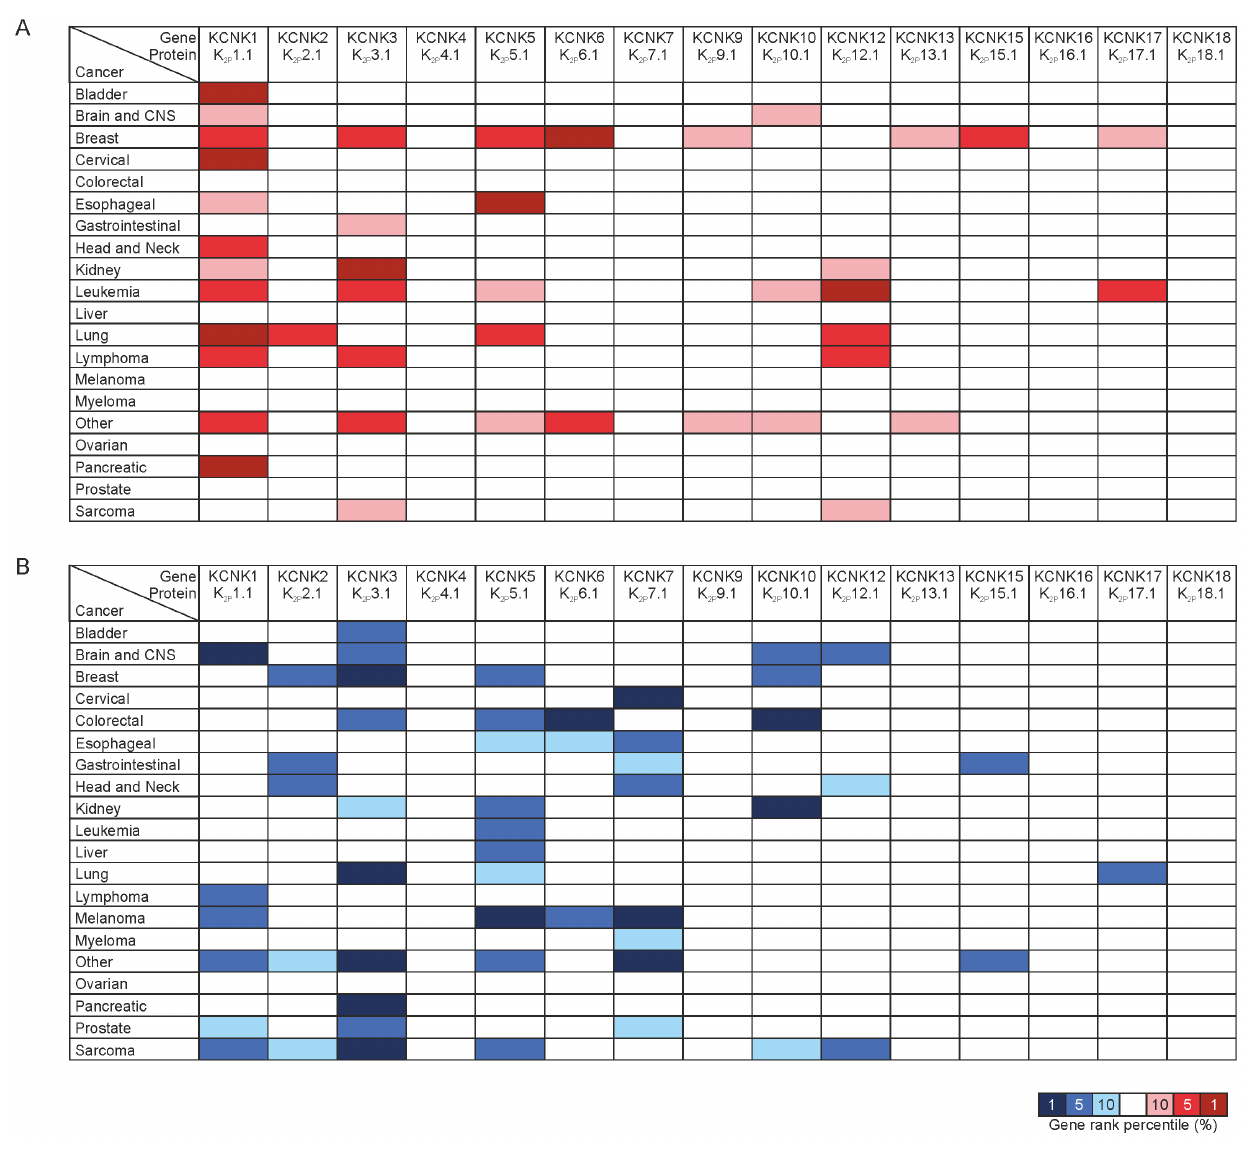
Figure 1. Expression of KCNK genes across different cancers. Expression of KCNK genes (KCNK1–18) in 20 cancers compared to normal tissue controls. Shown is the gene and protein names for each channel. A) overexpression of KCNK genes. B) underexpression of KCNK genes. Cancer types are organised by their tissue of origin, the degree of colour correlates to the gene rank percentile of the highest ranking analyses. Search criteria were for mRNA datasets and cancer vs. normal analysis only, with threshold values of p-value , 0.05, fold change . 2 and gene rank percentile , 10%.